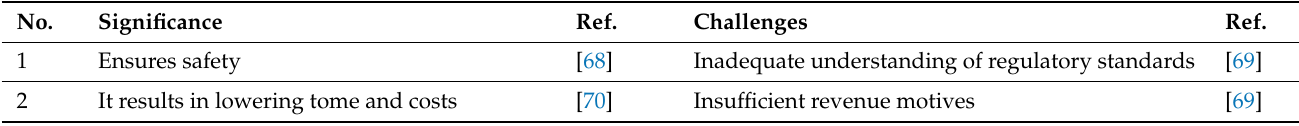
Table 2. The importance and difficulties of medication